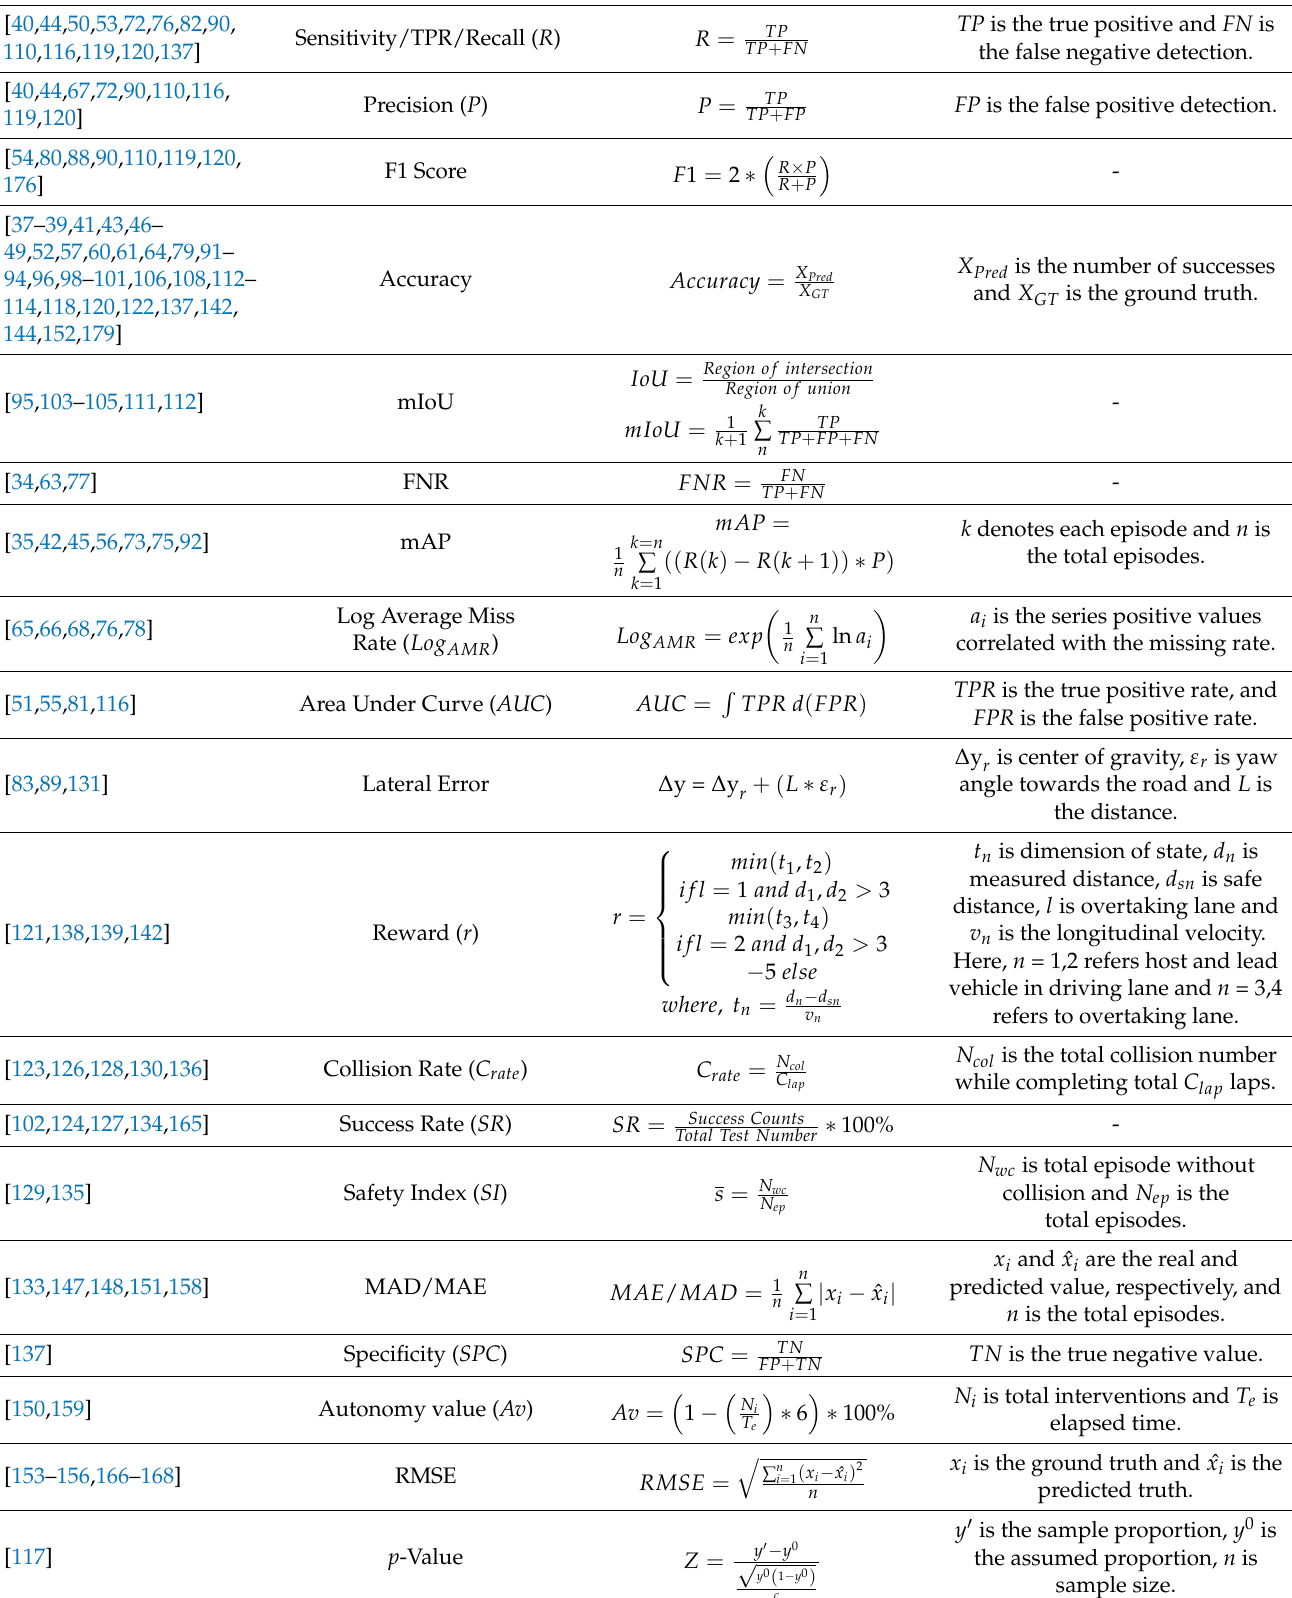
Table 14. Evaluation